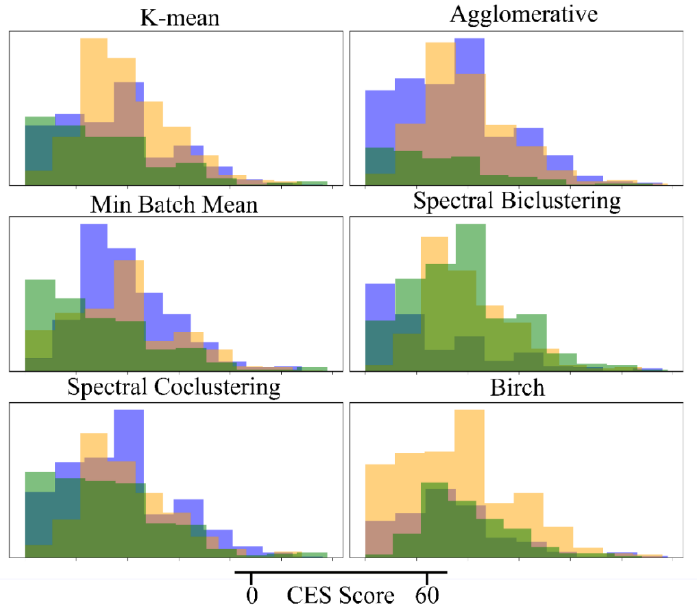
Figure 3. The effect of other kinds of clustering models in detecting the depression risk.